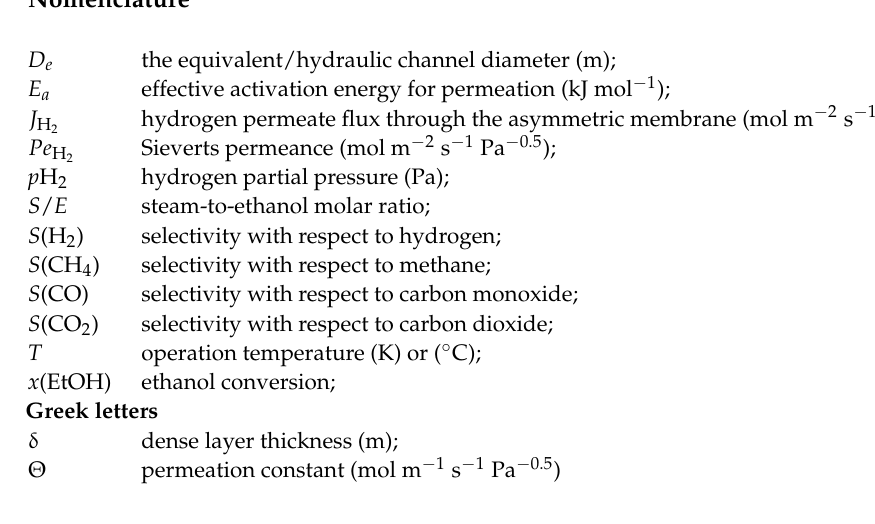
Figure S8: Dependencies of ethanol steam reforming products concentrations (a), ethanol conversion and product selectivities (b) on temperature. Steam to ethanol ratio 4, ethanol inlet concentration 12 vol.%, Figure S9: Dependencies of ethanol steam reforming products concentrations (a), ethanol conversion and product selectivities (b) on temperature. Steam to ethanol ratio 4, ethanol inlet concentration 16 vol.%, Figure S10: Dependencies of ethanol steam reforming products concentra- tions (a), ethanol conversion and product selectivities (b) on temperature. Steam to ethanol ratio 4, ethanol inlet concentration 20 vol.%, Figure S11: Dependencies of ethanol steam reforming products concentrations (a), ethanol conversion and product selectivities (b) on temperature. Steam to ethanol ratio 2, ethanol inlet concentration 6 vol.%, Figure S12: Dependencies of ethanol steam reforming products concentrations (a), ethanol conversion and product selectivities (b) on temperature. Steam to ethanol ratio 2, ethanol inlet concentration 13 vol.%, Figure S13: Dependencies of ethanol steam re- forming products concentrations (a), ethanol conversion and product selectivities (b) on temperature. Steam to ethanol ratio 2, ethanol inlet concentration 20 vol.%, Figure S14: Dependencies of ethanol steam reforming products concentrations (a), ethanol conversion and product selectivities (b) on temperature. Steam to ethanol ratio 2, ethanol inlet concentration 27 vol.%, Figure S15: Dependencies of ethanol steam reforming products concentrations (a), ethanol conversion and product selectivities (b) on temperature. Steam to ethanol ratio 2, ethanol inlet concentration 33